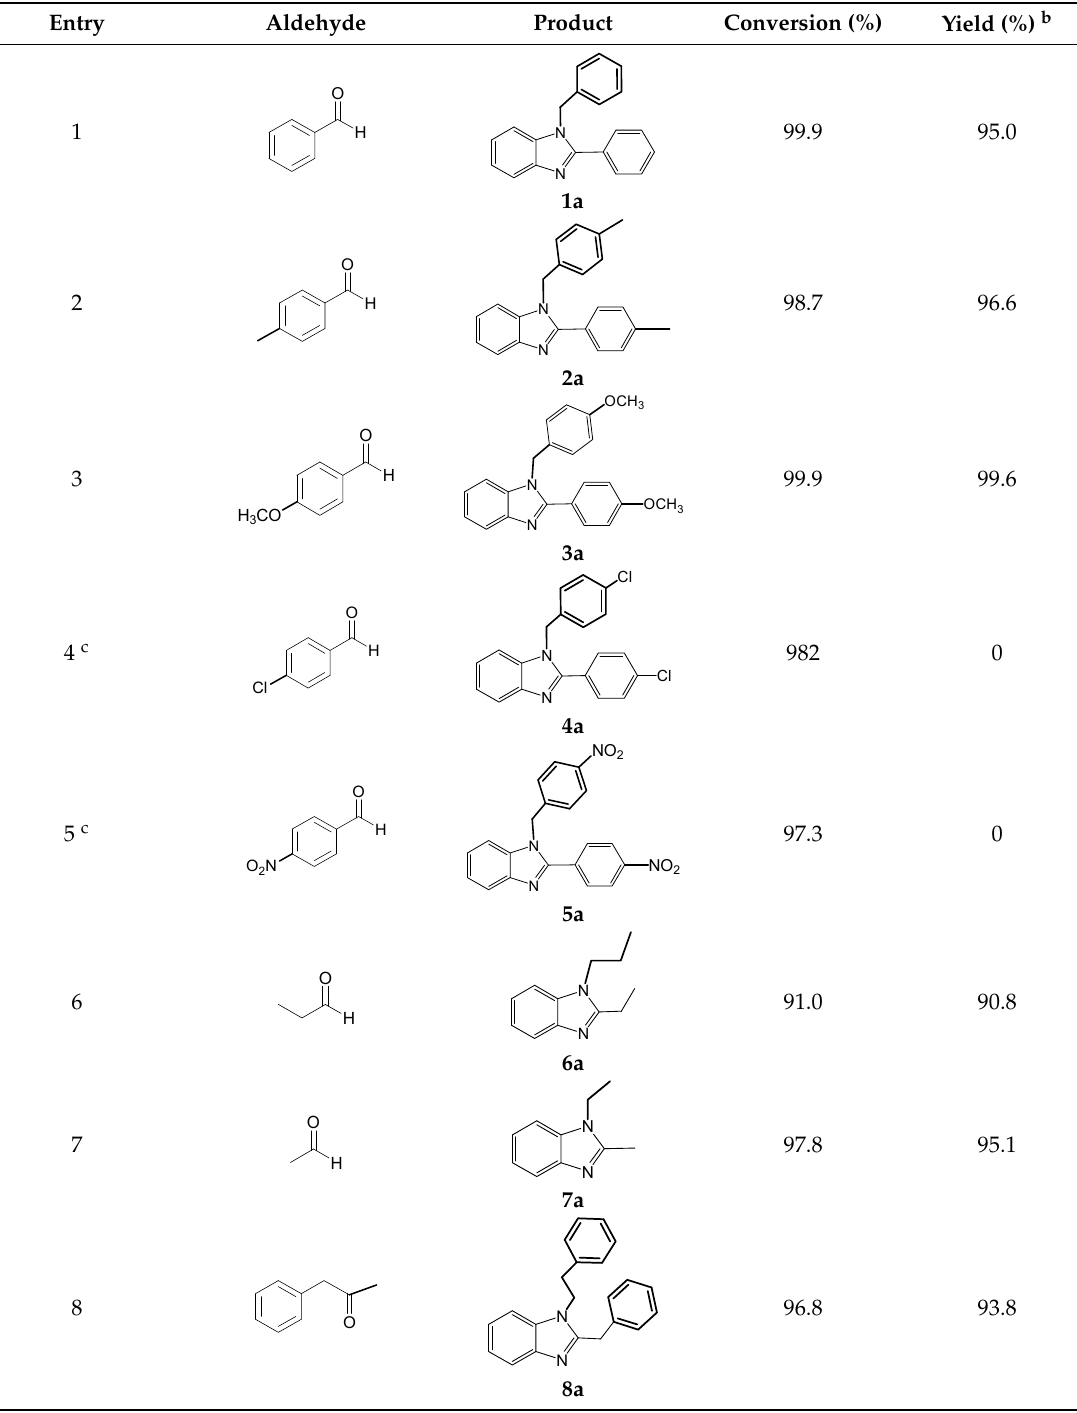
Table 3. Synthesis of 2-monosubstituted benzimidazoles. a